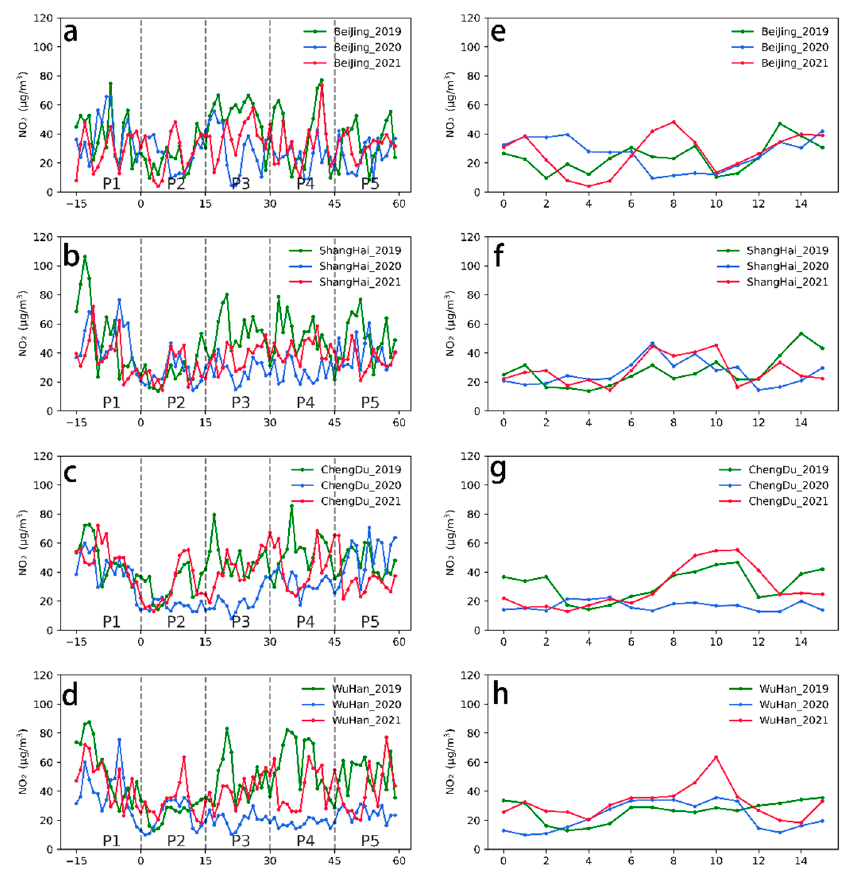
Figure 8. Time series of the daily mean ground-level NO 2 values for 2021 and 2019, ( a – d ) P1–P5, ( e – h ) P2 (Chinese New Year holiday).